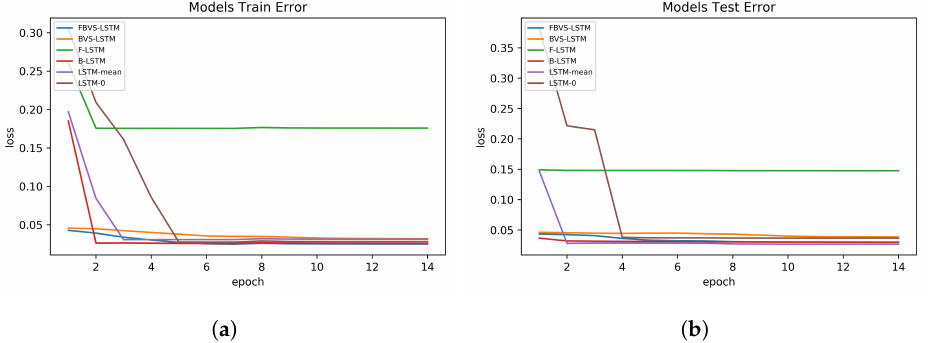
Figure 8. Models performance in Beijing Multi-Site Air-Quality dataset. ( a ) Training set errors; ( b ) Test set errors.